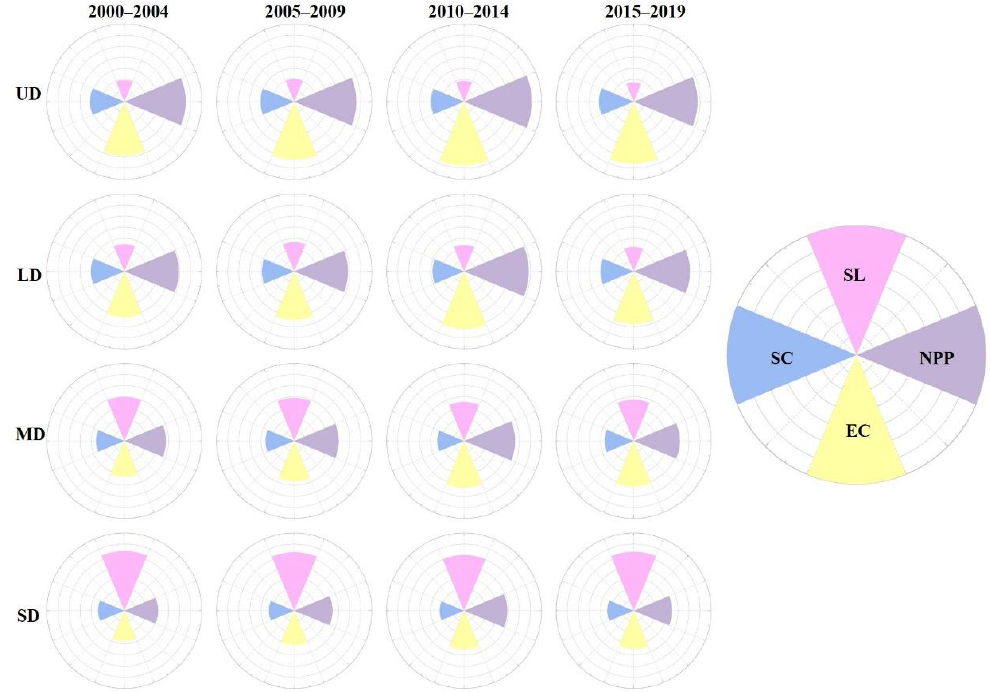
Figure 7. Rose chart of ecosystem services with different degradation degrees in the study area, from 2000 to 2019. UD, undegraded grassland; LD, lightly degraded grassland; MD, moderately degraded grassland; SD, severely degraded grassland; NPP, net primary production (kg C/m 2 ); EC, ecosystem carbon (kg C/m 2 ); SC, soil conservation (t/ha); SL, soil loss by wind (kg/m 2 ). Compared with SC and SL, the NPP and EC of undegraded and lightly degraded grassland always maintained a relatively higher level, which indicated that the NPP and